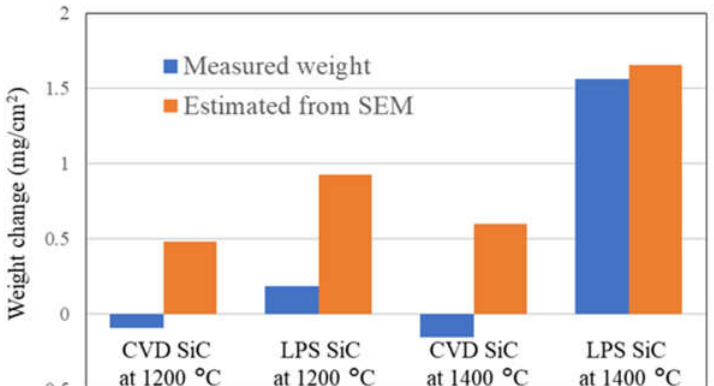
Figure 5. Measured from SEM images and assumed weight changes of the CVD SiC and the LPS-SiC following steam oxidation for 72 h at 1200 and 1400 °C.